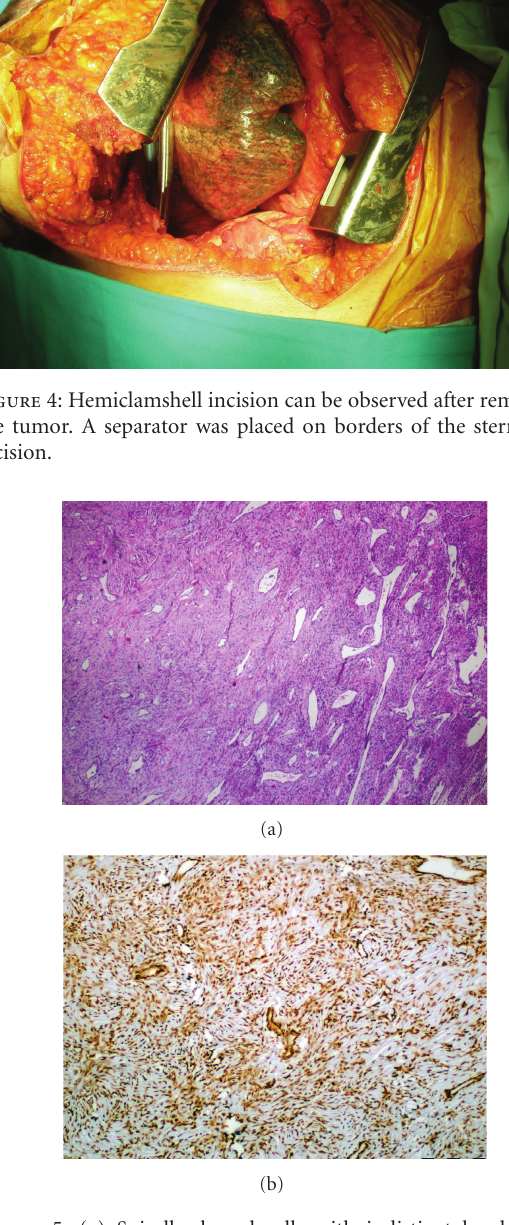
Figure 5: (a) Spindle-shaped cells with indistinct borders and branching hemangiopericytoma-like vessels (H & E, × 100). (b) Strong immuno-reactivity of the tumor cells for CD34 in solitary fibrous tumor (CD34, ×